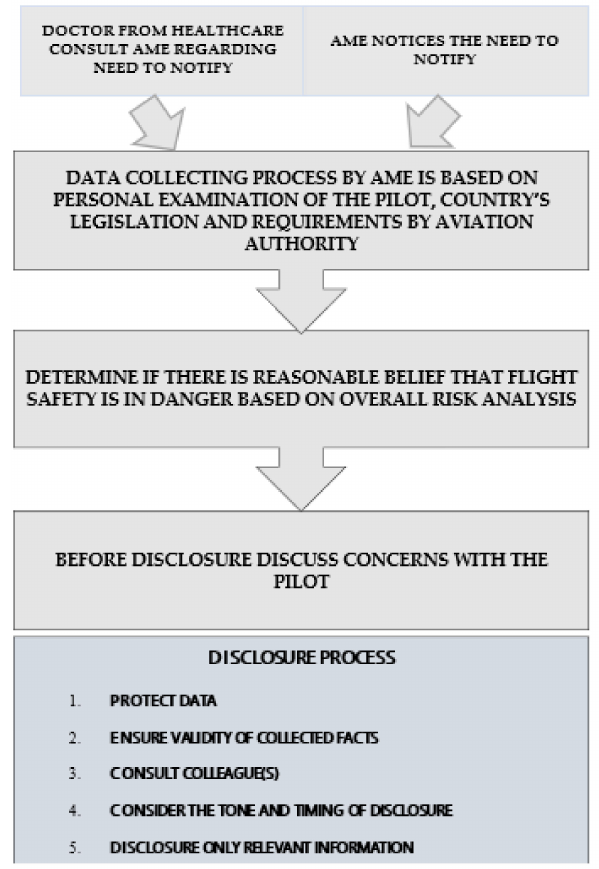
Figure 1. The key elements in the process of data collecting and